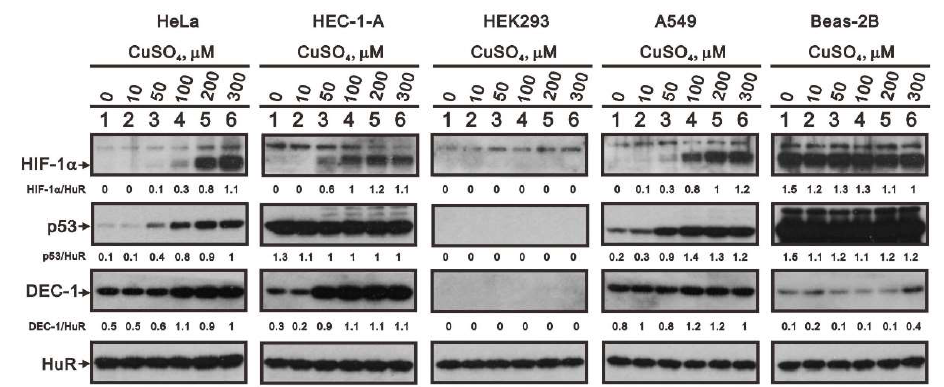
10 of 18 Figure 7. Copper sulfate acts via DEC1 to increase expression of related proteins. After DEC1 knockdown in HeLa cells, the cells were incubated for 6 h with the indicated concentrations of copper sulfate. Cell lysates were then subjected to western blotting with antibodies against DEC1, HIF-1α, p53, total and p-ERK, and p62. ACTN served as the loading control. The results are representative of three independent experiments. Protein bands were quantified through pixel density scanning and evaluated using ImageJ, version 1.44a (http://imagej.nih.gov/ij/). The fold (shown above the bands) was normalized to internal control (ACTN). Phosphorylated ERK after normalization to total ERK protein is shown as the fold change. 2.6. The Cell Type-Dependent Effects of Copper Sulfate on the Stability of HIF-1α Finally, to determine whether the effects of copper sulfate were cell type-specific, we compared its effects on HIF-1α, p53, and DEC1 expression in HEC-1-A human endometrial adenocarcinoma, HEK293 human embryonic kidney, A549 human pulmonary adenocarcinoma, and Beas-2B immortalized normal human bronchial epithelial cells with those in HeLa cells (Figure 8). Our